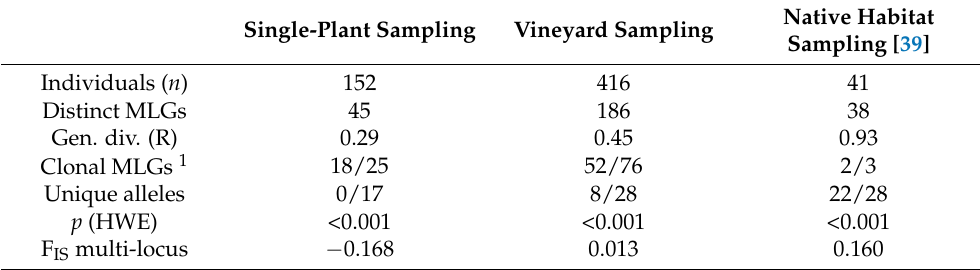
Table 3. Genetic diversity parameters based on four SSRs (PhyIII55, PhyIII30, PhyIII36, and Dvit6) for phylloxera populations in the 2018 and 2019 sampling (excluding samples outside the netting system), and for those sampled in their native habitat according to Tello et al. [31].